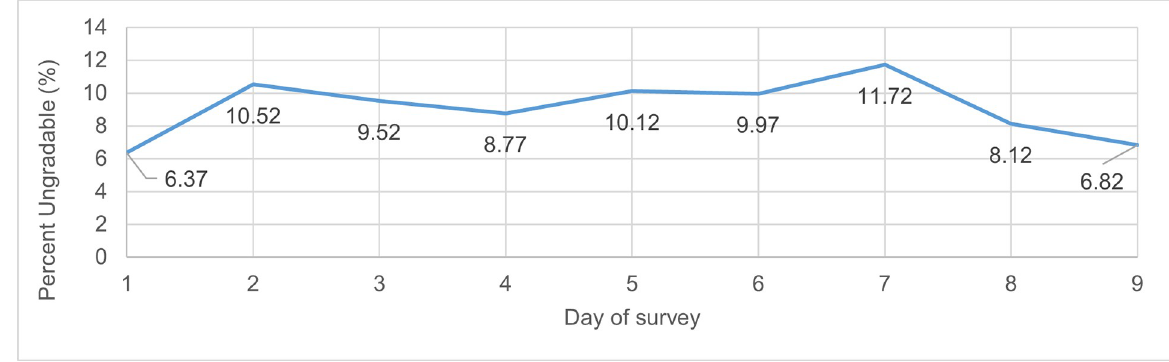
Fig 4. Percentage of ungradable images over the survey duration.